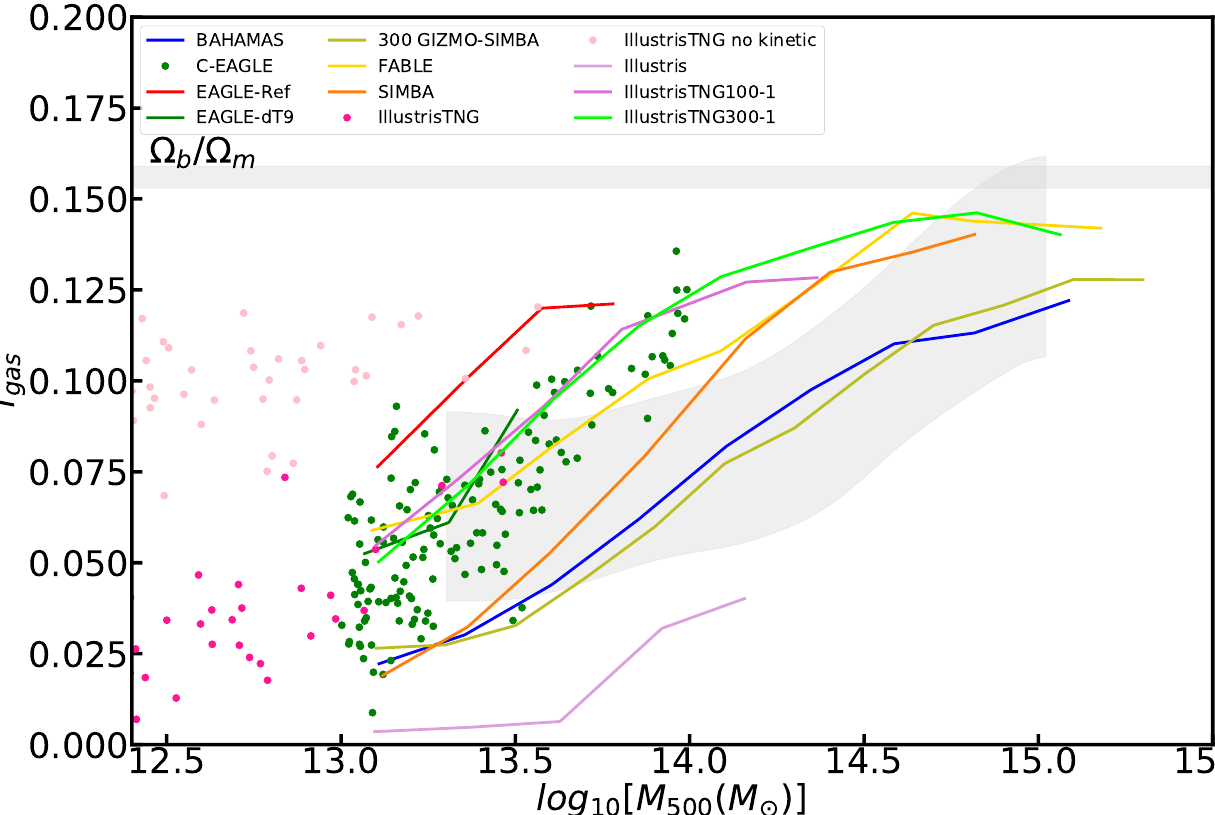
Figure 15. Compilation of gas fractions within R 500 from modern simulations as a function of M 500 . The blue line corresponds to BAHAMAS [41], the red and green lines to the Reference and dT9 models of EAGLE [284], the green symbols to C-EAGLE and Hydrangea [317,318], as it uses the same sub-grid model as EAGLE-dT9, the olive line to the 300 clusters run with the GIZMO-SIMBA code (Cui et al. in preparation) as part of The Three Hundred Project [313], the salmon line to Horizon-AGN [283], the gold one to FABLE [282], the orange one to SIMBA [287,288], and the pink and deep pink symbols, as well as the plum, orchid, and lime lines correspond to various models from the Illustris and IllustrisTNG suites [285,286]. The compilation of observations presented in Figure 7 is shown as a gray